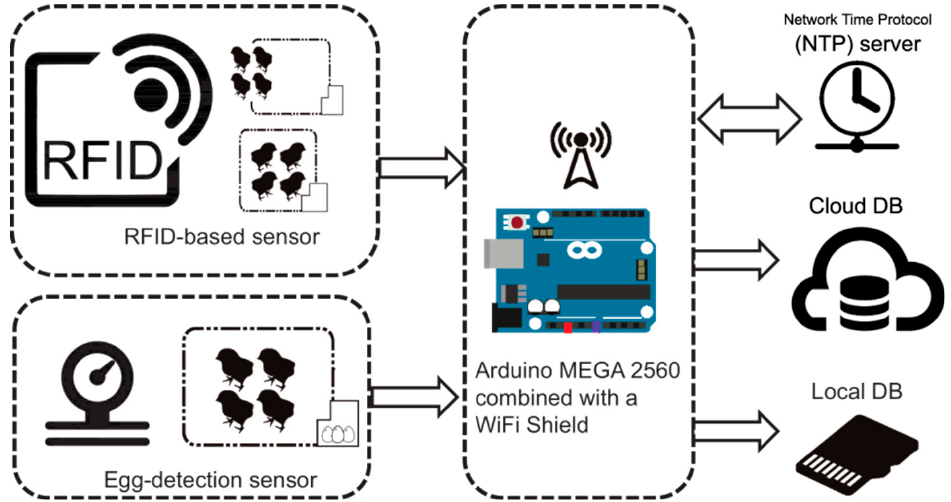
Figure 16. Block diagram of IoT platform for poultry-laying performance and behavior monitoring [70].